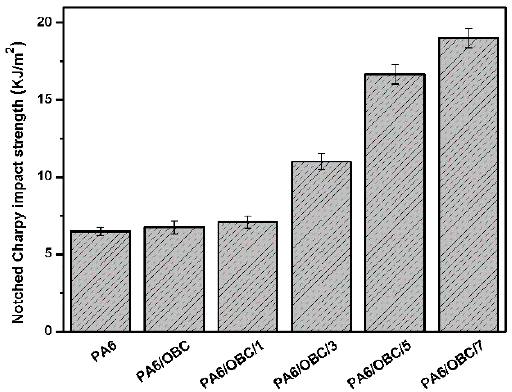
Figure 9. Notched Charpy impact strength of pure PA6, and the PA6/OBC and PA6/OBC/POE-g- MAH blends at various POE-g-MAH contents.